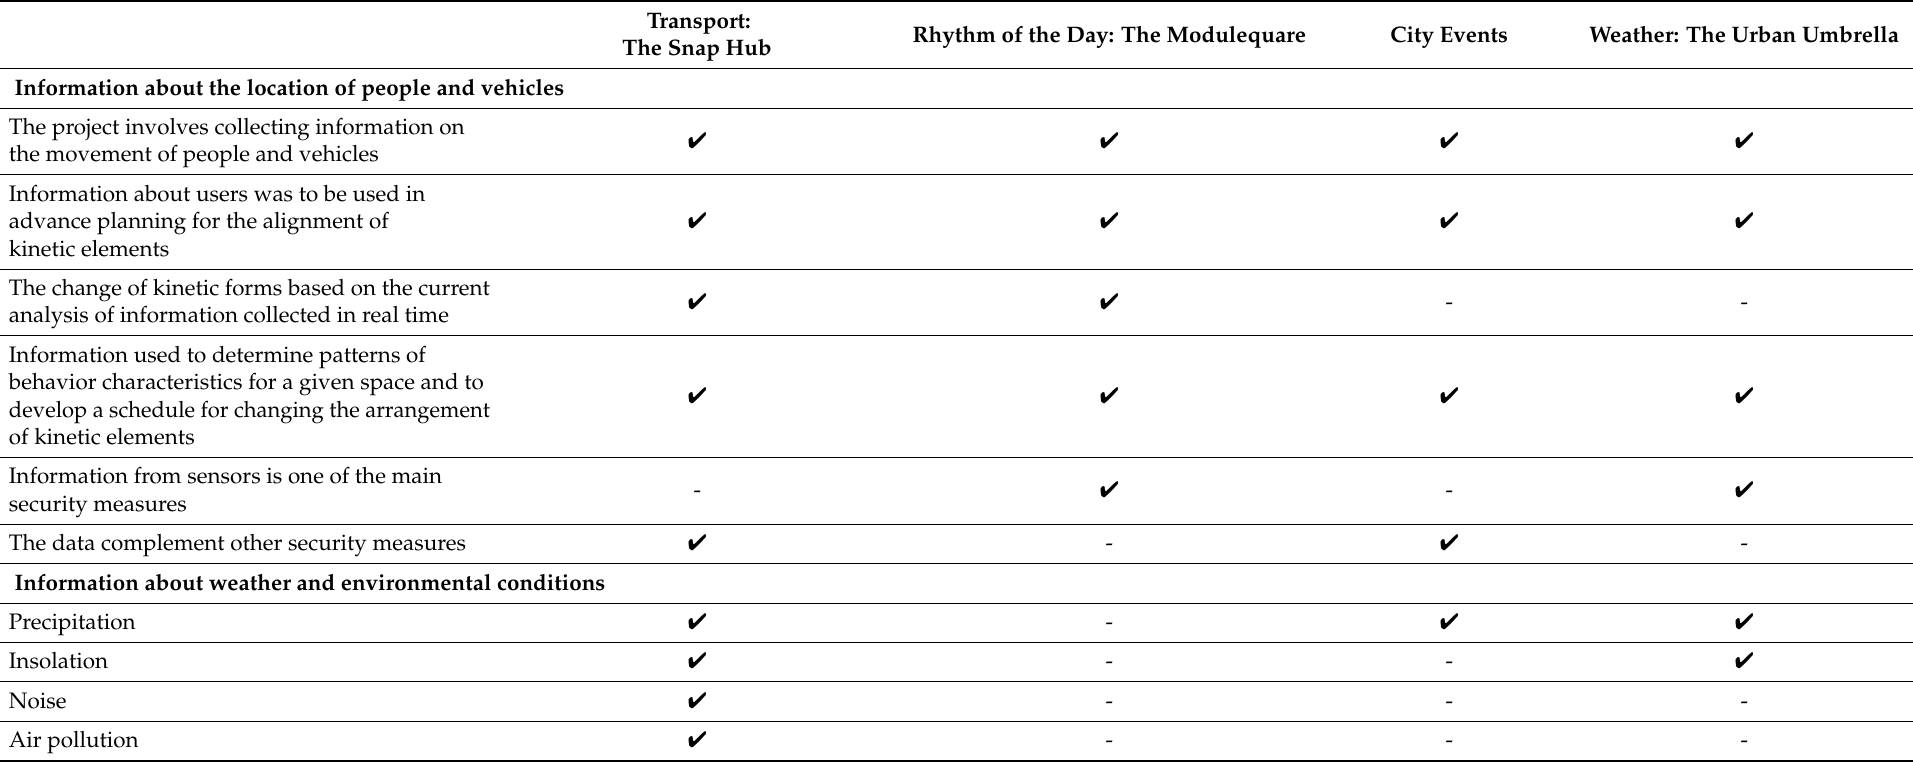
Table 2. Summary of the use of dynamically collected data about users, weather and climatic conditions in individual, analyzed projects. Transport: Rhythm of the Day: The Modulequare City Events Weather: The Urban The Snap Hub